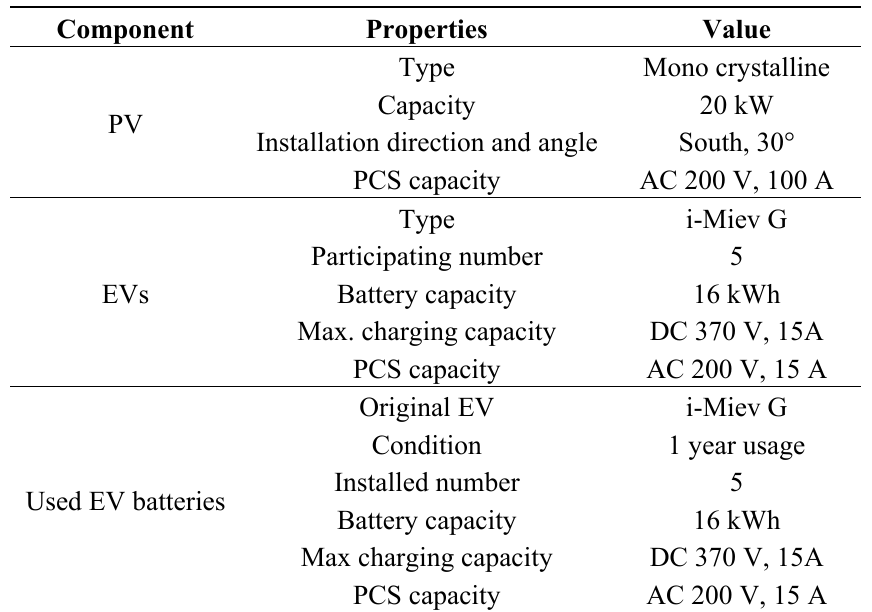
Table 1. Specifications of developed demonstration test